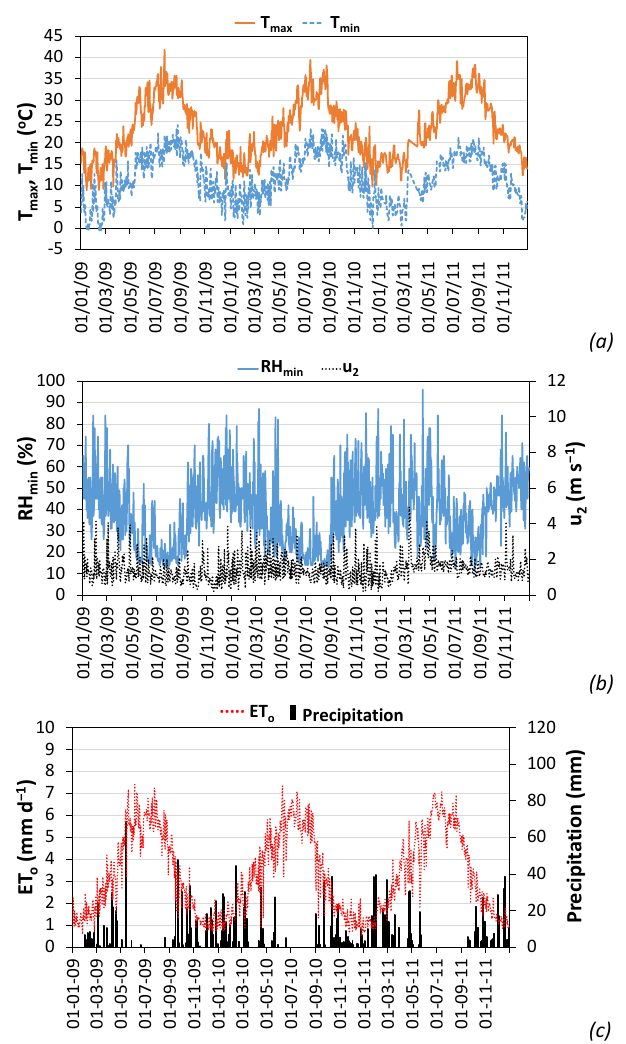
Figure 1. Main daily-observed climatic variables at the weather station of Castelvetrano in 2009, 2010, and 2011: ( a ) maximum (T max ) and minimum (T min ) temperatures, ( b ) minimum relative air humidity (RH min ) and wind speed at 2 m height (u 2 ), and ( c ) precipitation and FAO Penman–Monteith reference crop evapotranspiration (ET o ).